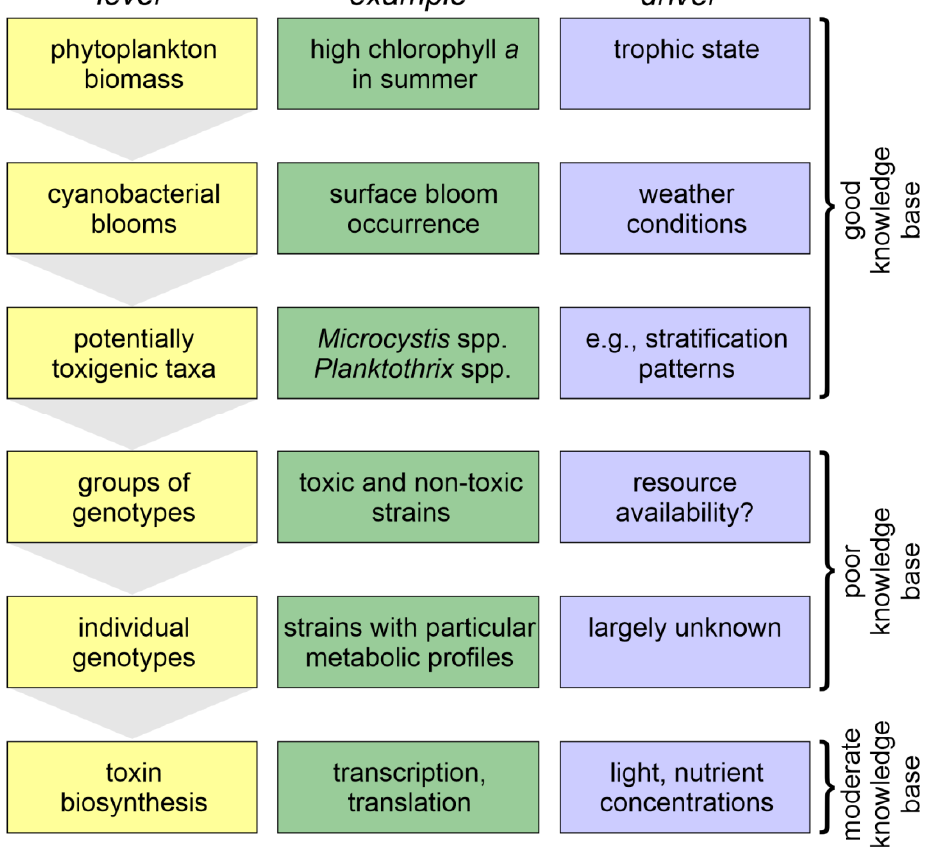
Figure 2. Levels at which environmental conditions drive cyanotoxin occurrence and concentrations.